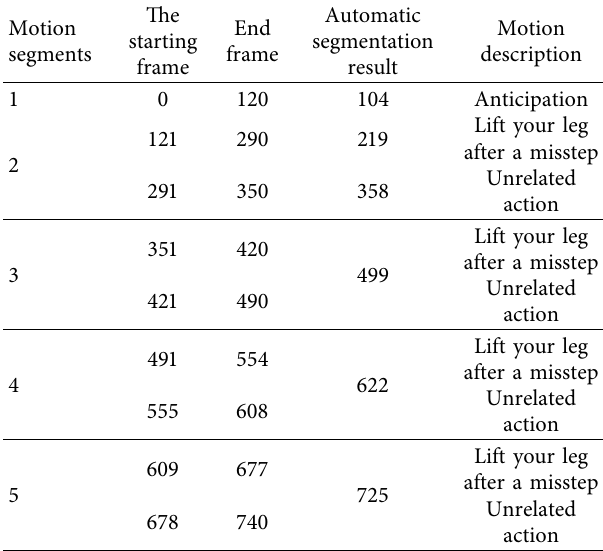
Table 4: Comparison of segmentation locations with added